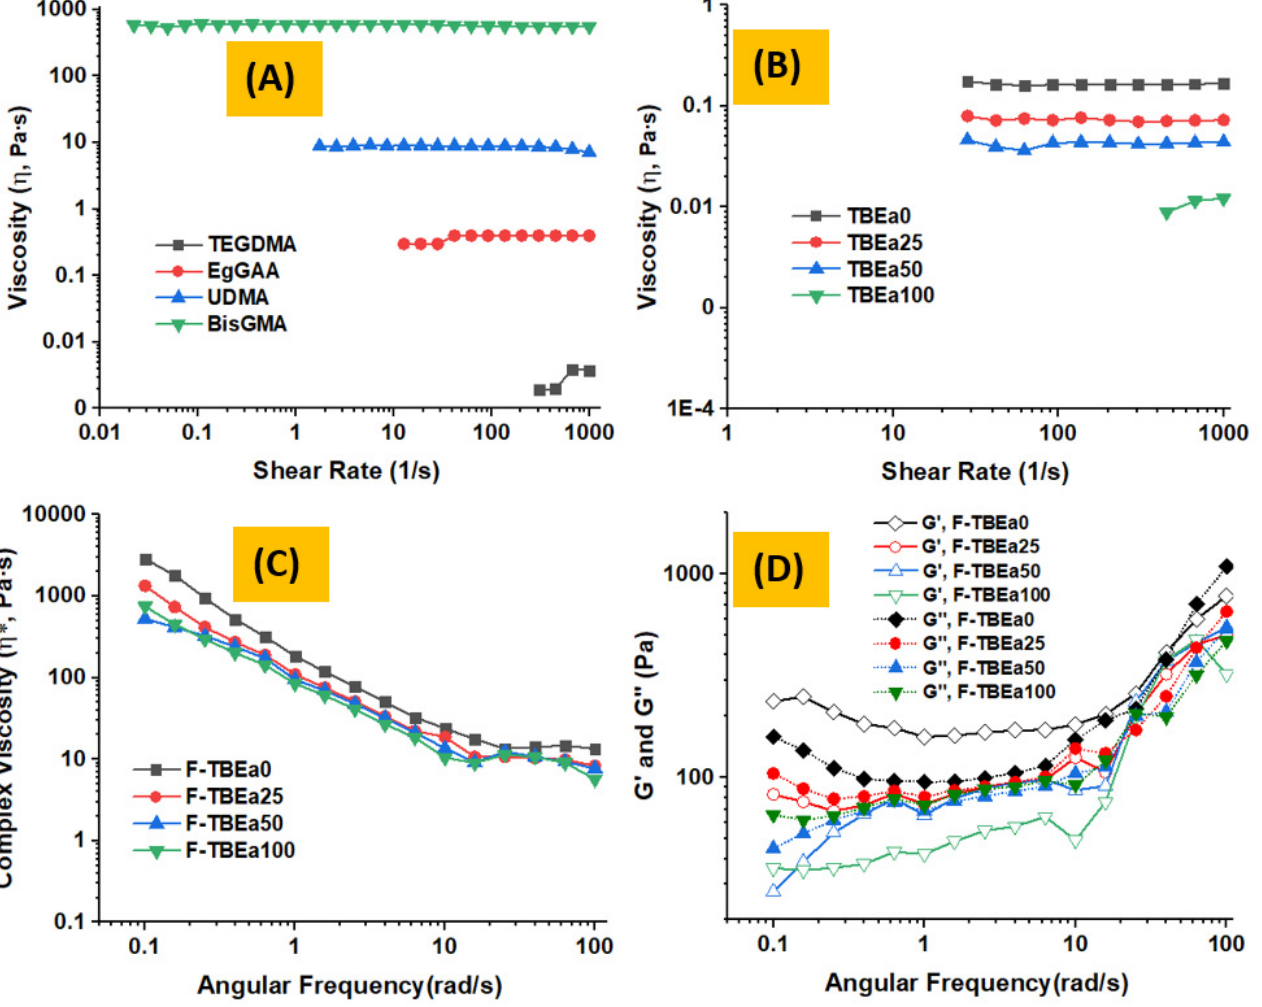
Figure 7. ( A ) Rheometrically analyzed: ( A ) viscosity of monomers (TEGDMA, EgGAA, UDMA, and BisGMA); ( B ) viscosity of resin matrices (TBEa(0–100)), ( C ) complex viscosity of prepared resin composites (F-TBEa(0–100)), ( D ) storage (G ′ ) and loss (G ″ ) moduli of F-TBEa(0–100) composites.